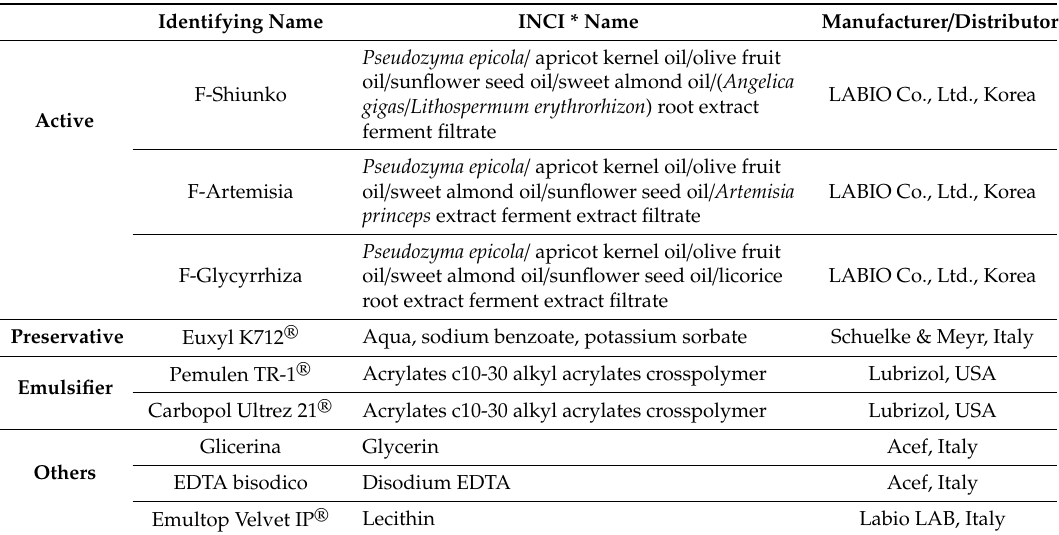
Table 1. Overview of all materials used in this